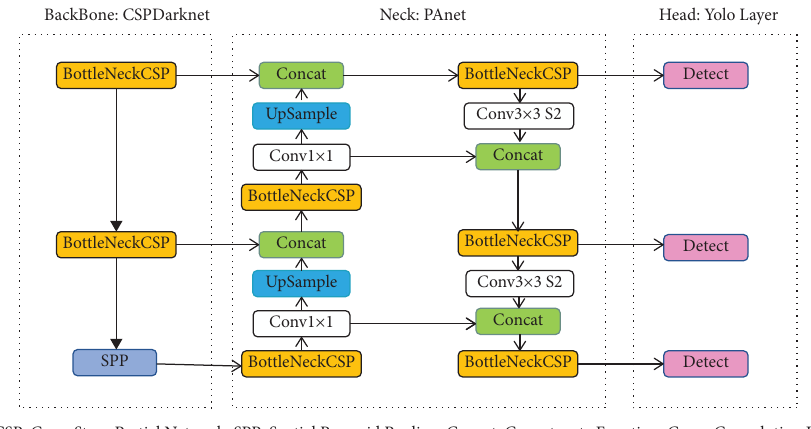
Figure 2: YOLOv5’s default structure: the data are frst input to CSPDarknet for feature extraction and then fed to PANet for feature fusion. Finally, the Yolo layer outputs detection results (class, score, location, and size).